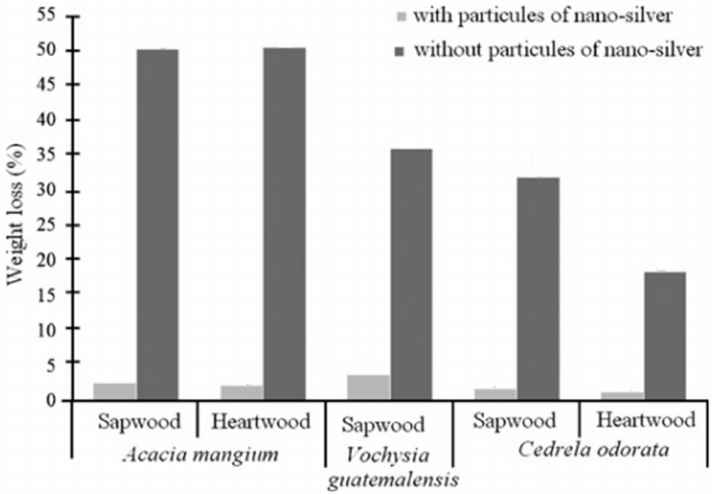
Figure 11. Relative weight loss in the wood samples with and without AgNPs treatment. The weight loss in wood is a condition of the rotting caused by Trametes versicolor. Image retrieved from